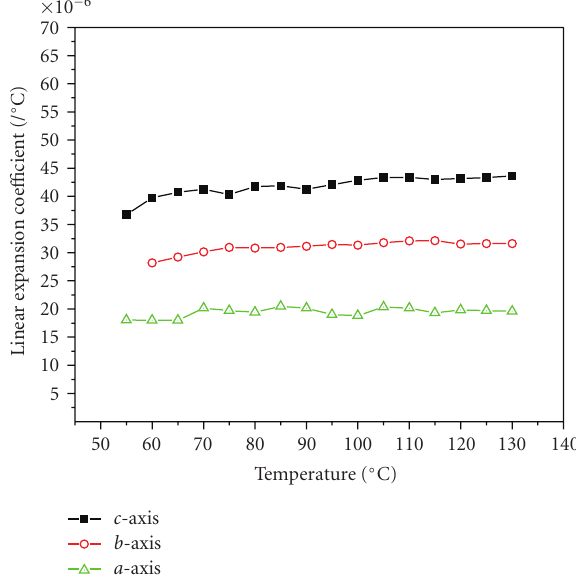
Figure 21: Anisotropy of linear expansion coe ffi cient along the three